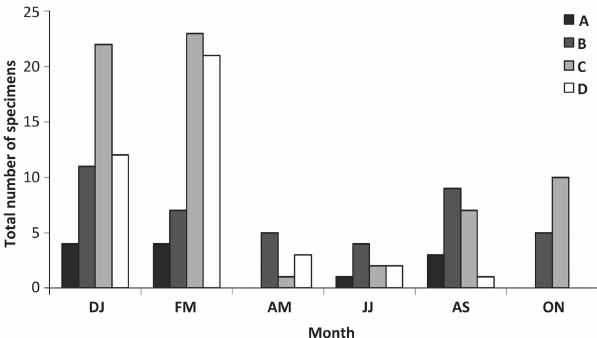
Fig. 11. Bimonthly distribution of gonad maturity stages of Loricariichthys melanocheilus males in the rio Ibicuí, Rio Grande do Sul. DJ = December/January, FM = February/ March, AM = April/May; JJ = June/July, AS = August/ September, ON = October/November); A = immature, B = developing, C = mature D = spent.